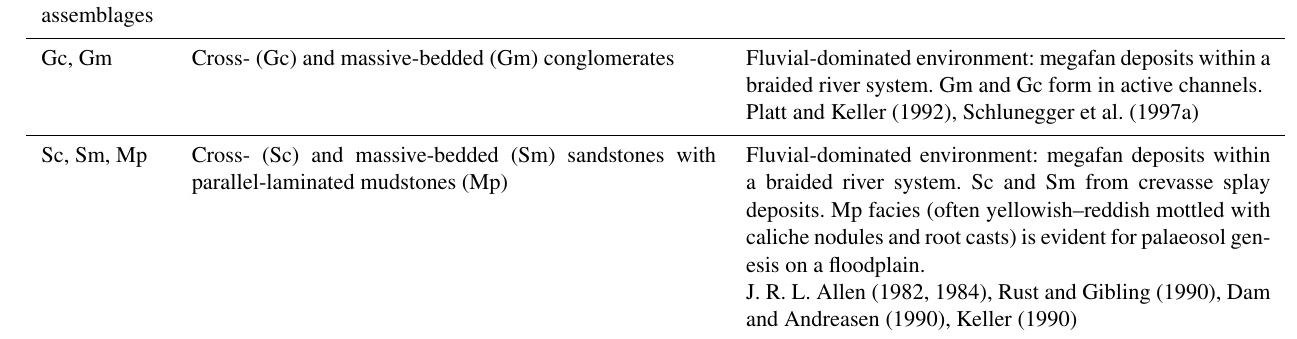
Table 2. Lithofacies encountered in the Napf units. Facies